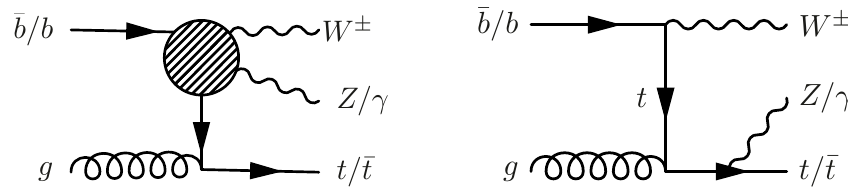
Figure 10. Left : schematic Feynman diagram for the EW-induced tZW / t(cid:13)W processes and the embeddings of the b W t Z and b W t Z subamplitudes. Right : sample Feynman diagram for ! ! the topologies which do not embed the subamplitudes of